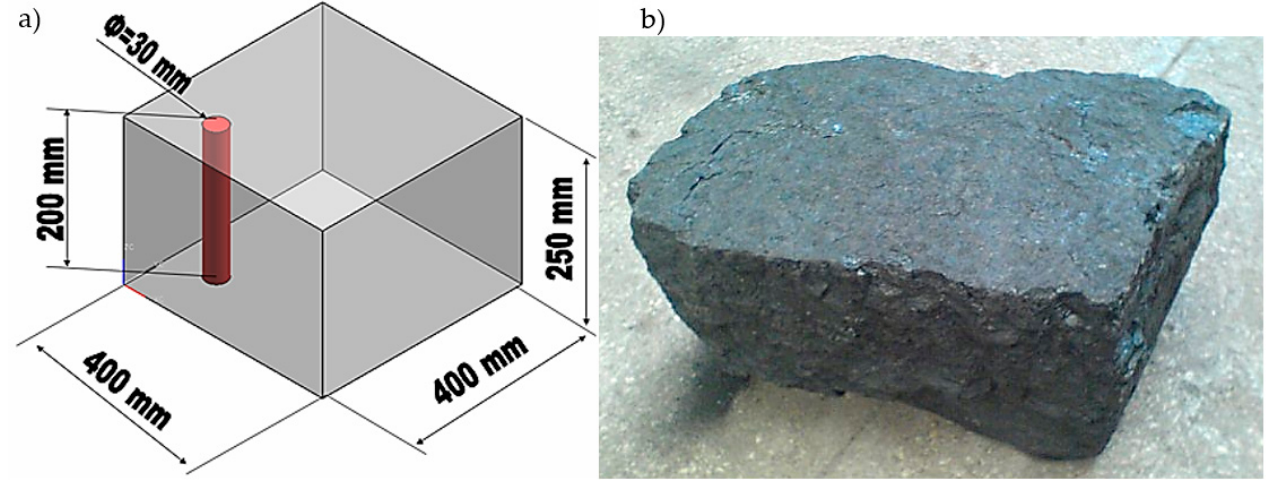
Figure 2. Visualization of a gasification reactor with a coal sample intended for gasification and a steam generator (12): a—reactor, k—steam generator, l—reactor lock.